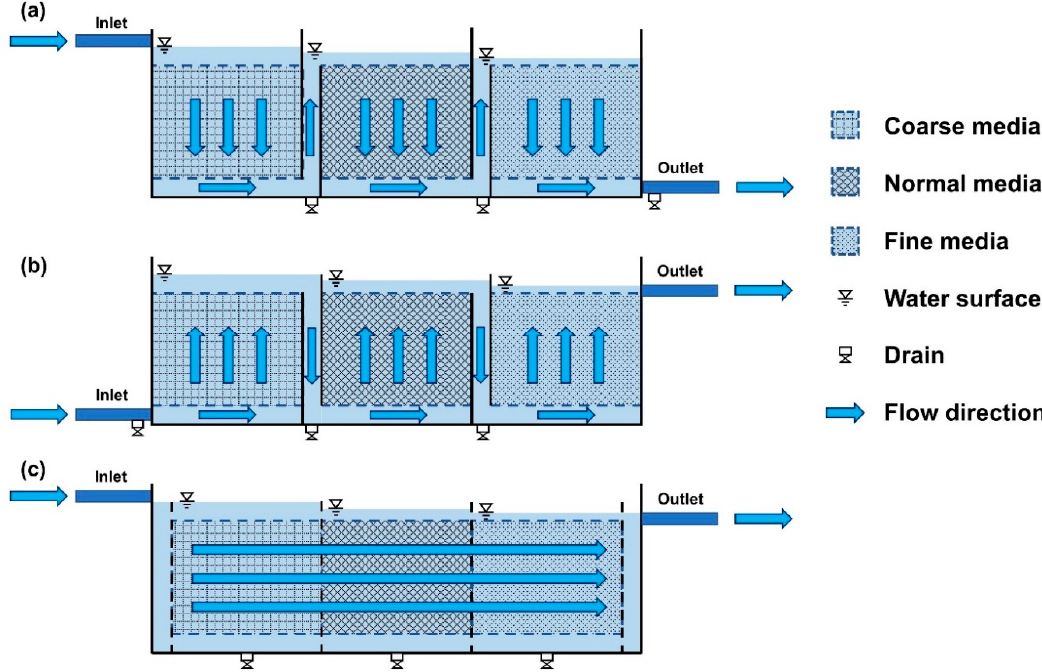
Figure 5. Schematics of horizontal and vertical roughing filters: ( a ) down-flow roughing filter, ( b ) up-flow roughing filter, and ( c ) horizontal-flow roughing filter [4,5,11].